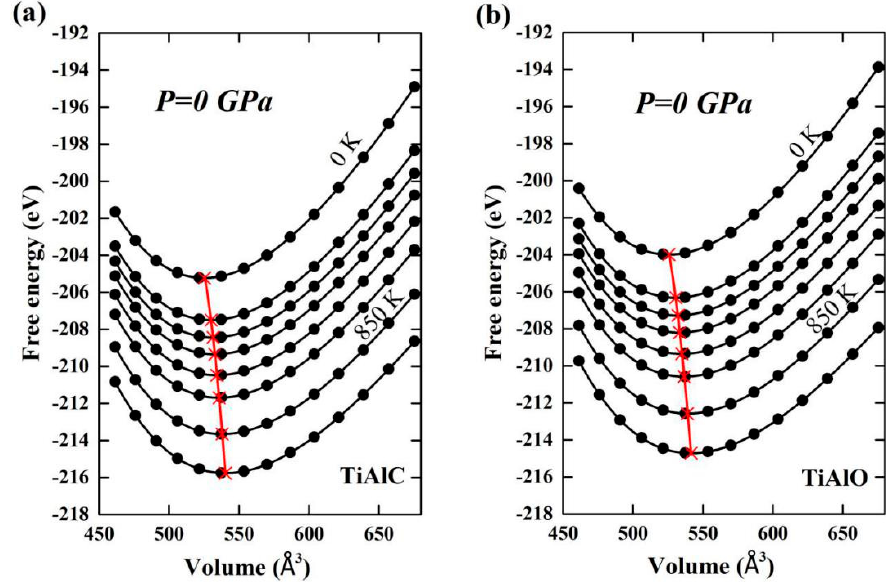
Figure 2. Volume-dependent Helmholtz free energy of TiAlC ( a ) and TiAlO ( b ). Red lines connect the equilibrium volume with the minimum free energy at every temperature, where red cross indicates the equilibrium volume of each temperature.